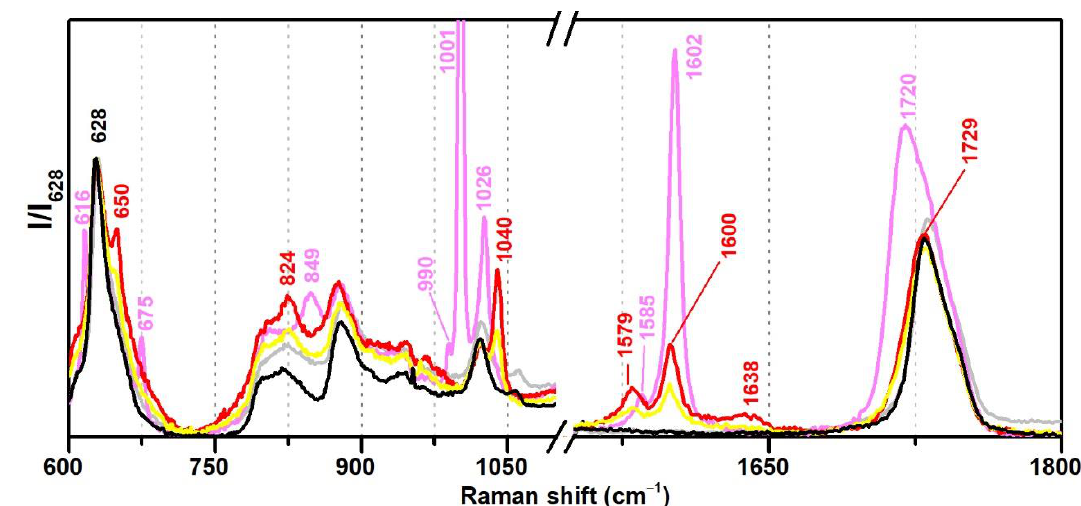
Figure 6. Raman spectra of the pure PVAc emulsion (black), Bizonte (pink), Vulcano V7 (red), and Imofan AV44/11 (yellow) between 600–1800 cm − 1 . According to the authors of [5], Bizonte is composed of PVAc plasticised with DPGDB and DEGDB, Vulcano V7 is composed of PVAc plasticised with DiBP, and Imofan AV44/11 is composed of P(VAc-VeoVa) plasticised with DiBP.